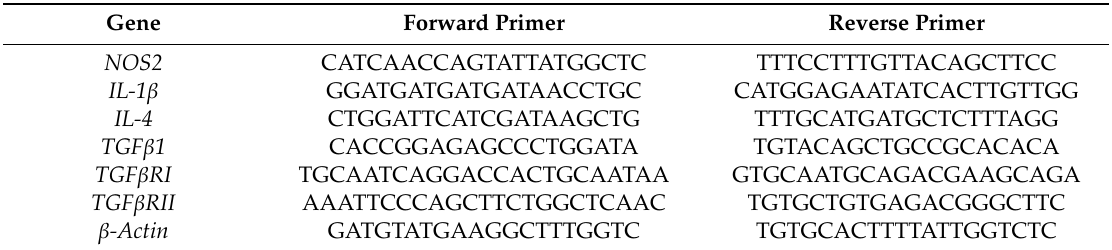
Table 2. List of primers and sequences used for quantitative